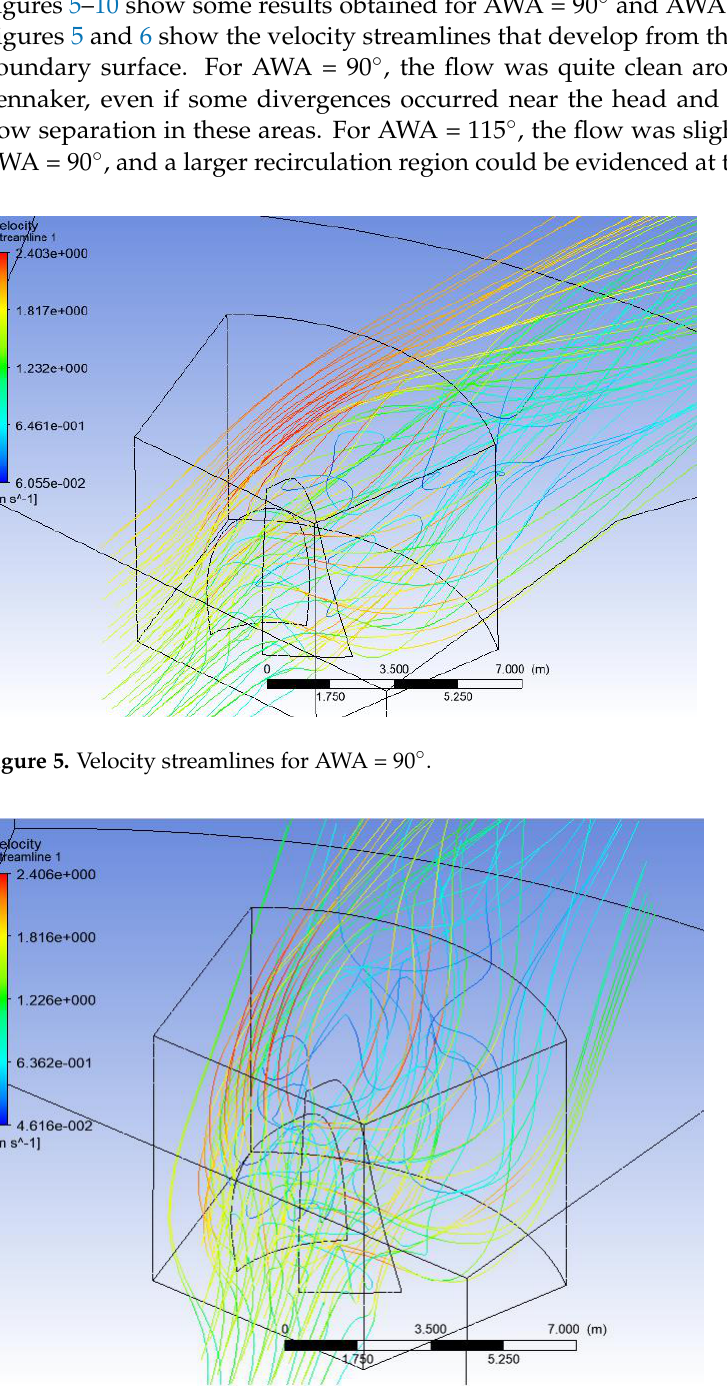
Figure 6. Velocity streamlines for AWA = 115°.